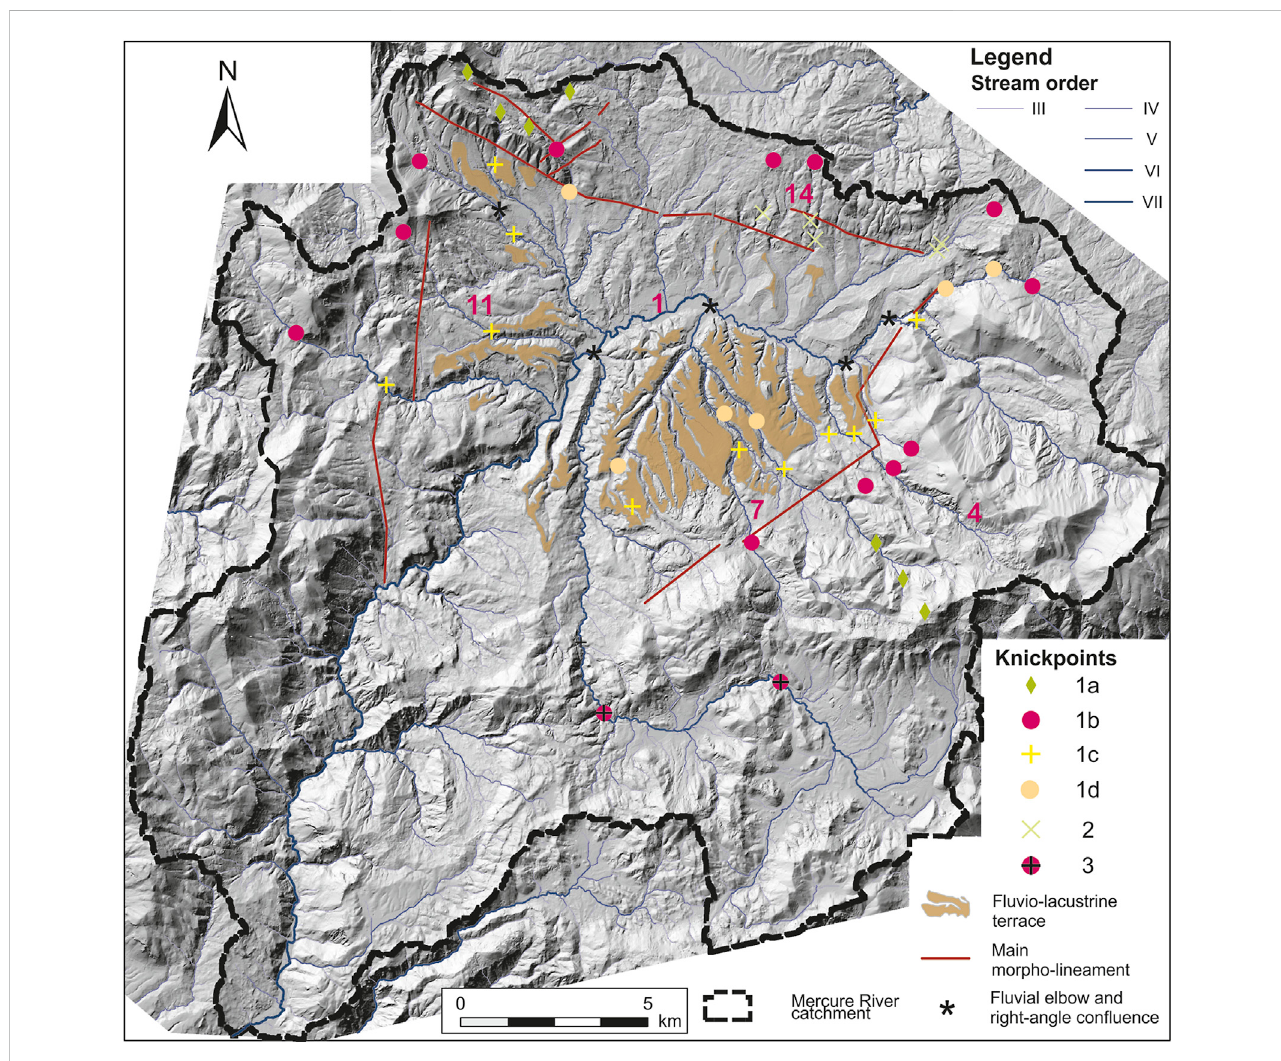
FIGURE 6 Morphotectonic map of the study area showing knickpoint distribution, fl uvio-lacustrine terraces, and the main morpho-lineaments. Legend: 1a, 1b, 1c, 1d: knickpoint related to the base-level falls; 2) end of knickzone related to the activity of the Castelluccio-Viggianello fault; 3) knickpoint related to fl uvial capture phenomena. Numbers in red indicate the location of channels investigated in Panel